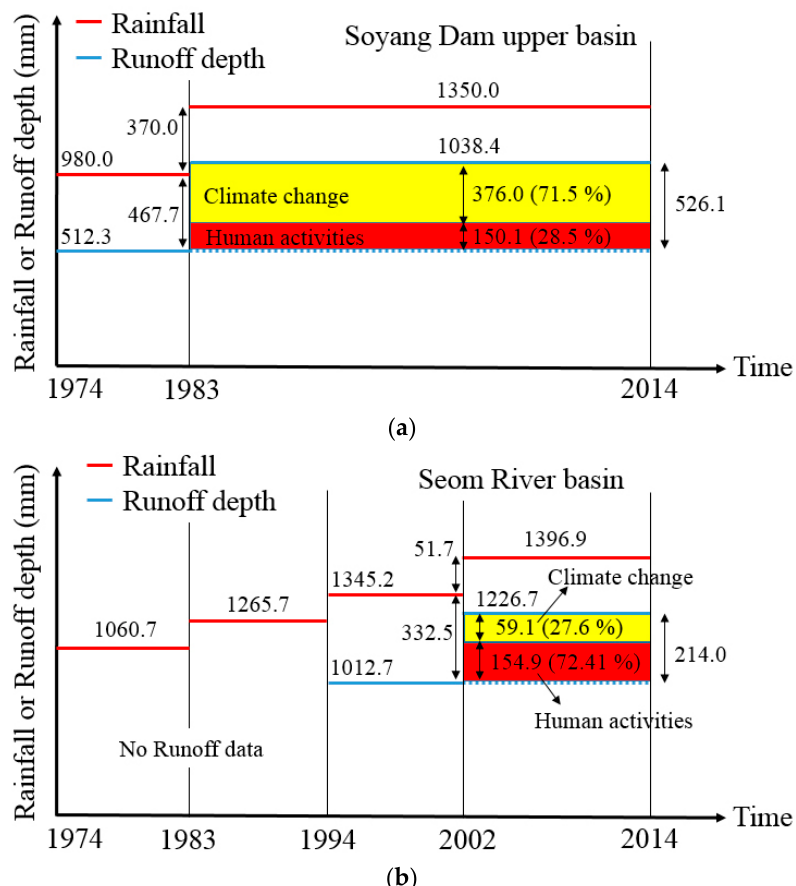
Figure 9. Summary of the hydrological modeling method on an annual scale. ( a ) Soyang Dam upper basin; ( b ) Seom River basin.